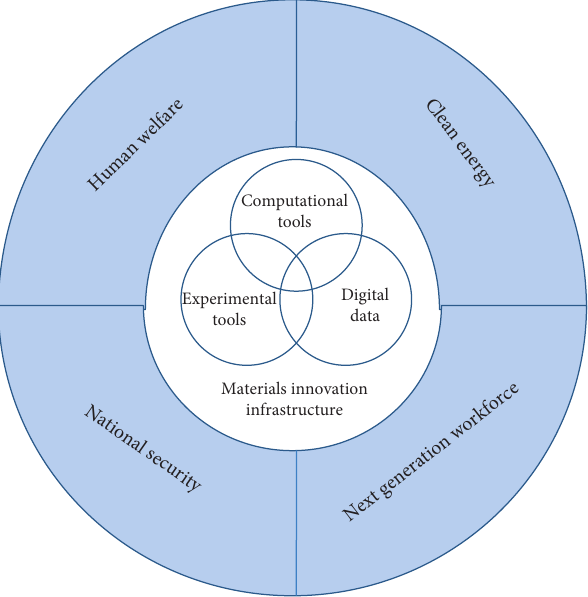
Figure 1: Implications of material innovation infrastructure in MGI